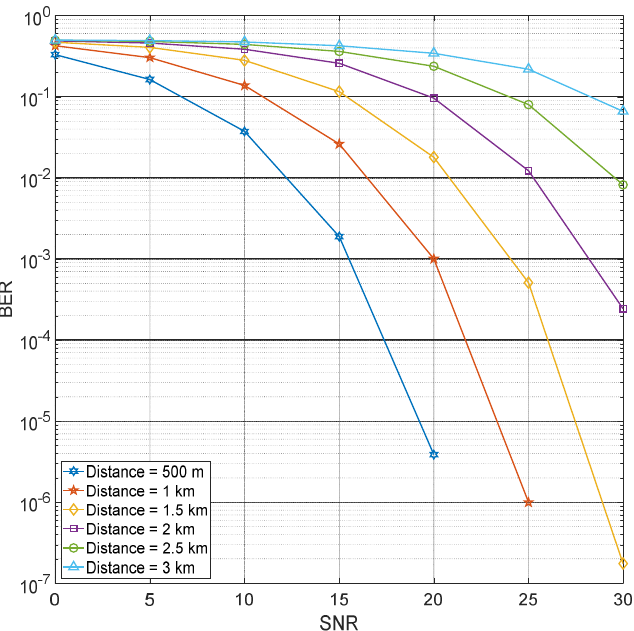
Figure 8. BER performance of CPM-OFDM as a function of transmitter-receiver distances with N = 512, h = 7/16.